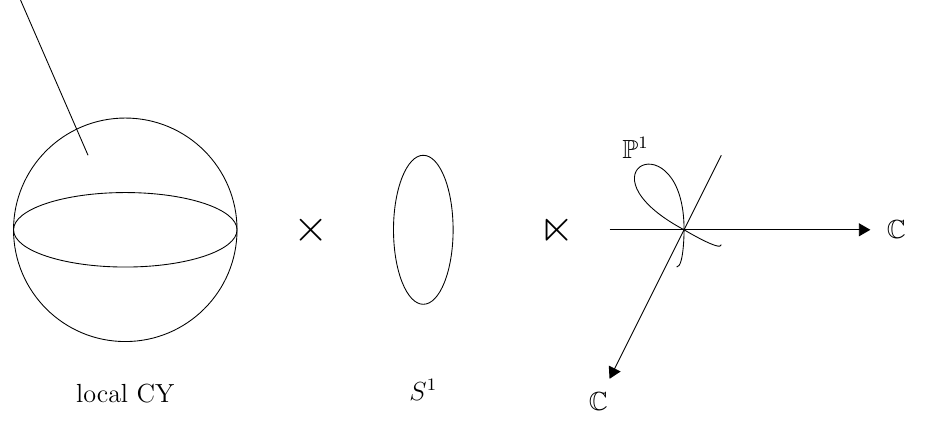
Figure 1 . The background of